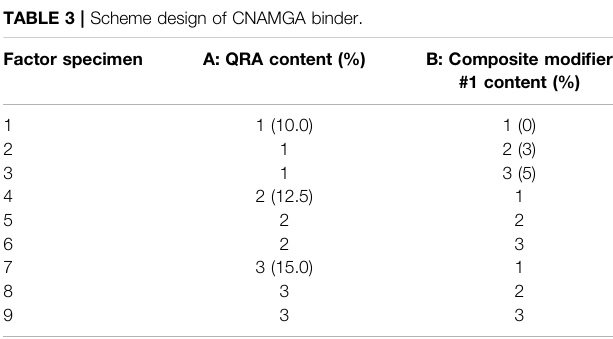
TABLE 3 | Scheme design of CNAMGA binder. Factor